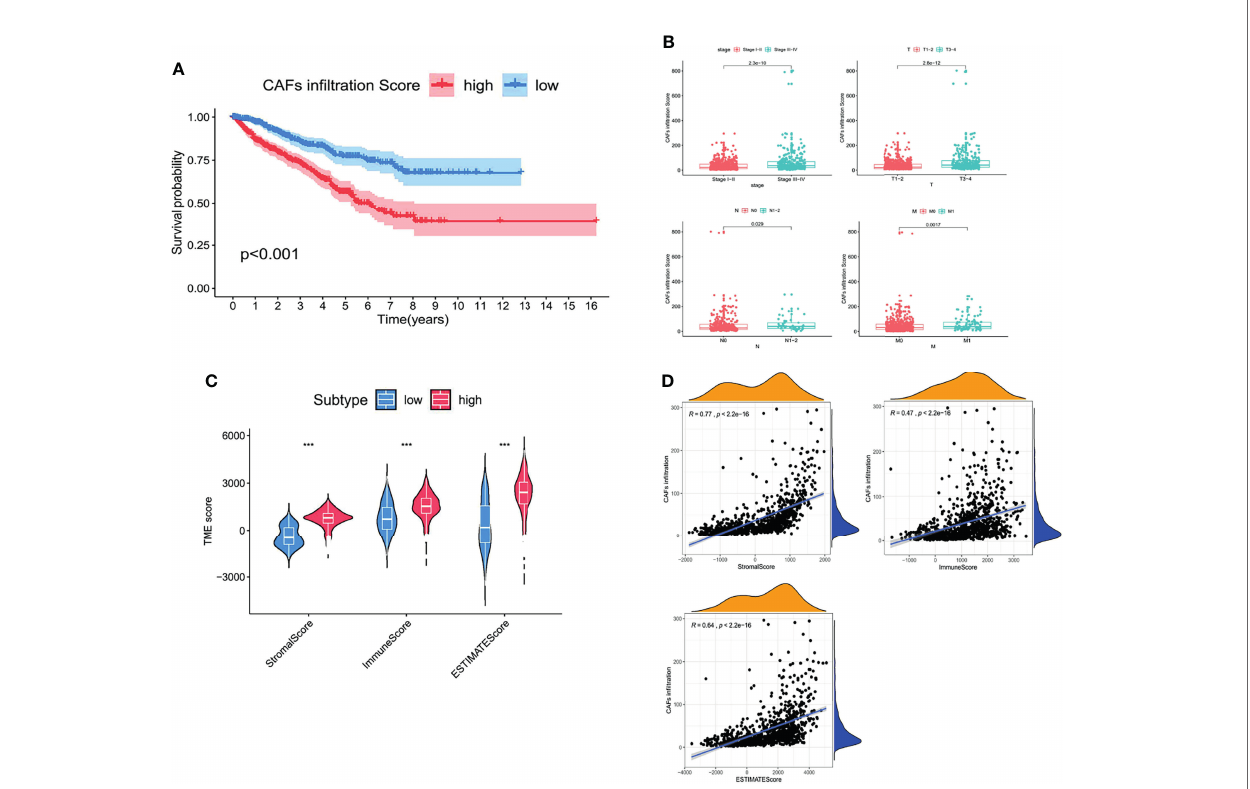
FIGURE 2 | CAFs constituted the major component of the TME and promoted RCC progression. (A) Kaplan – Meier analysis of the OS associated with high and low CAF in fi ltration. (B) Clinicopathological correlation of CAF in fi ltration in RCC. (C) Violin plot of the comparison of stromal and immune and ESTIMATE scores based on high and low CAF in fi ltration groups. (D) Correlation analysis between the CAF in fi ltration score and TME scores. p < 0.05 was considered statistically signi fi